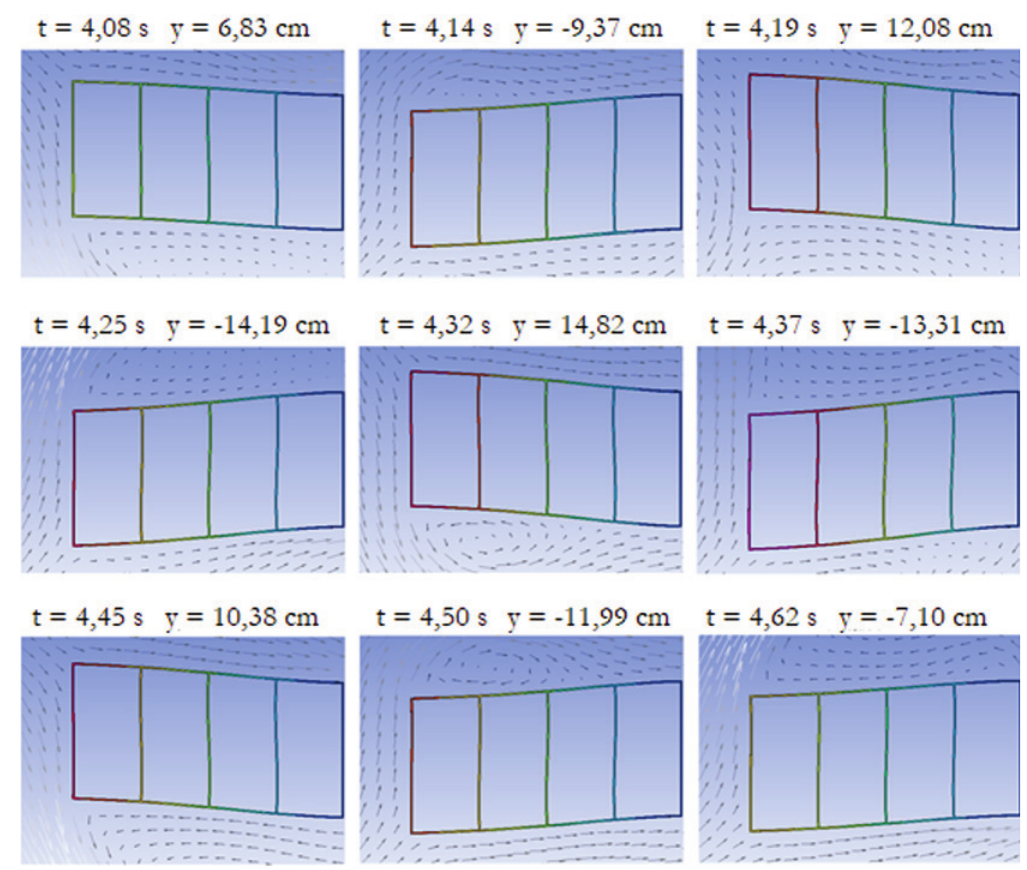
Movimento oscilatório da estrutura, onde: t é o tempo de simulação e y é o deslocamento